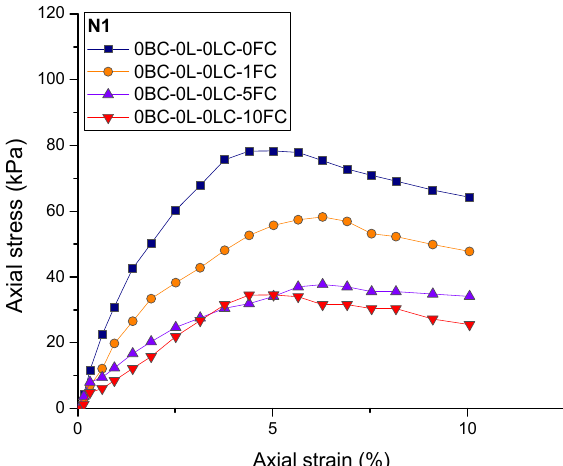
Figure 4. Stress–strain curves of loess without basalt fiber and lime reinforcement.